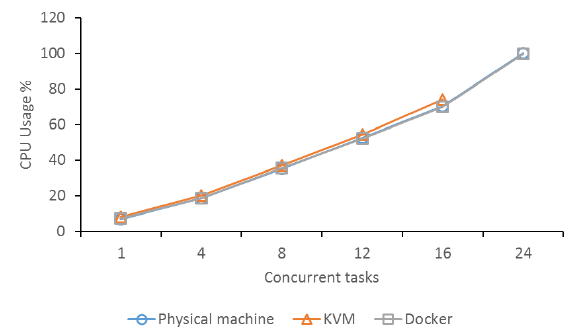
Figure 10. Host CPU usage of different concurrent